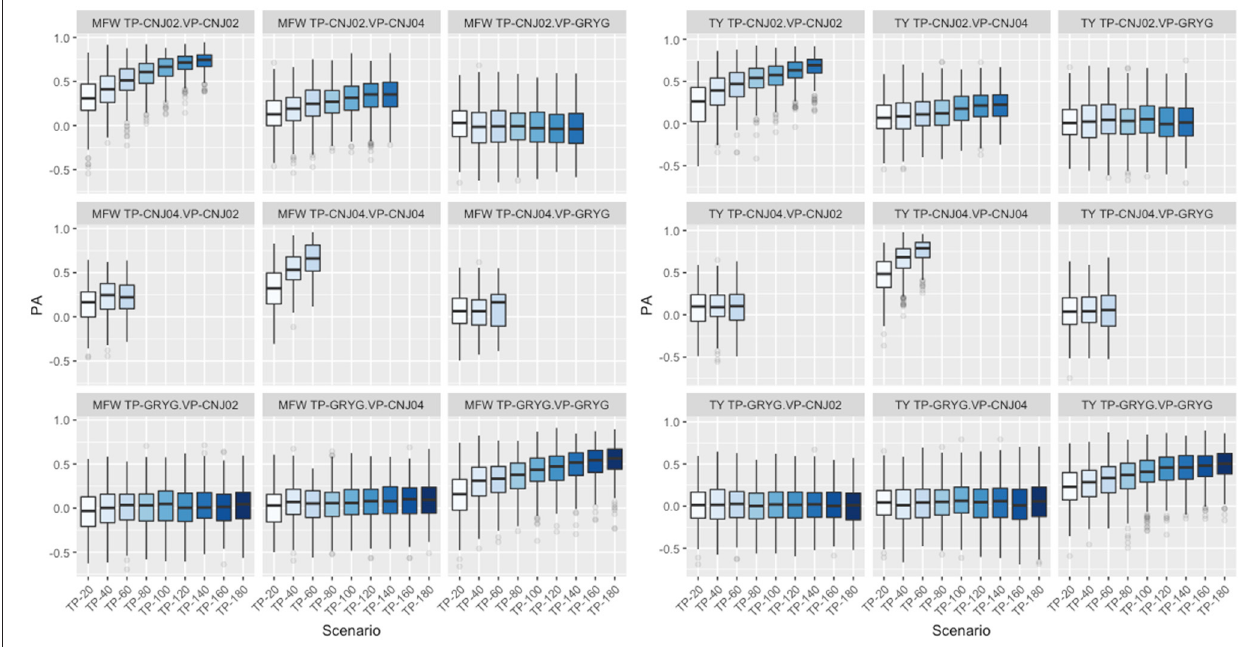
FIGURE 4 | Effect of degree of resemblance on the predictive ability on three biparental populations (CNJ02, CNJ04, and GRYG). The effect on predictive ability (PA) related to the familial relationship between the training population (TP) and validation population (VP) for mean fruit weight (MFW; left box) and total yield (TY; right box).